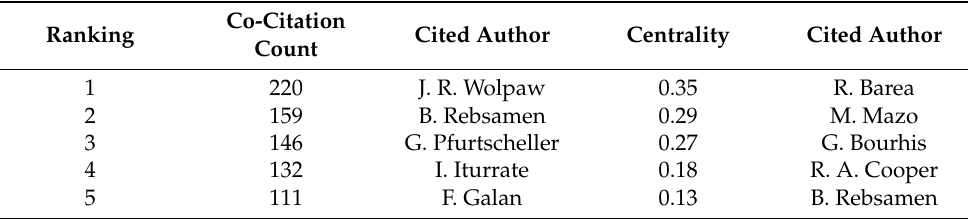
Table 6. Top 5 co-cited authors involved in EPW HMI methodology research in terms of co-citation count and